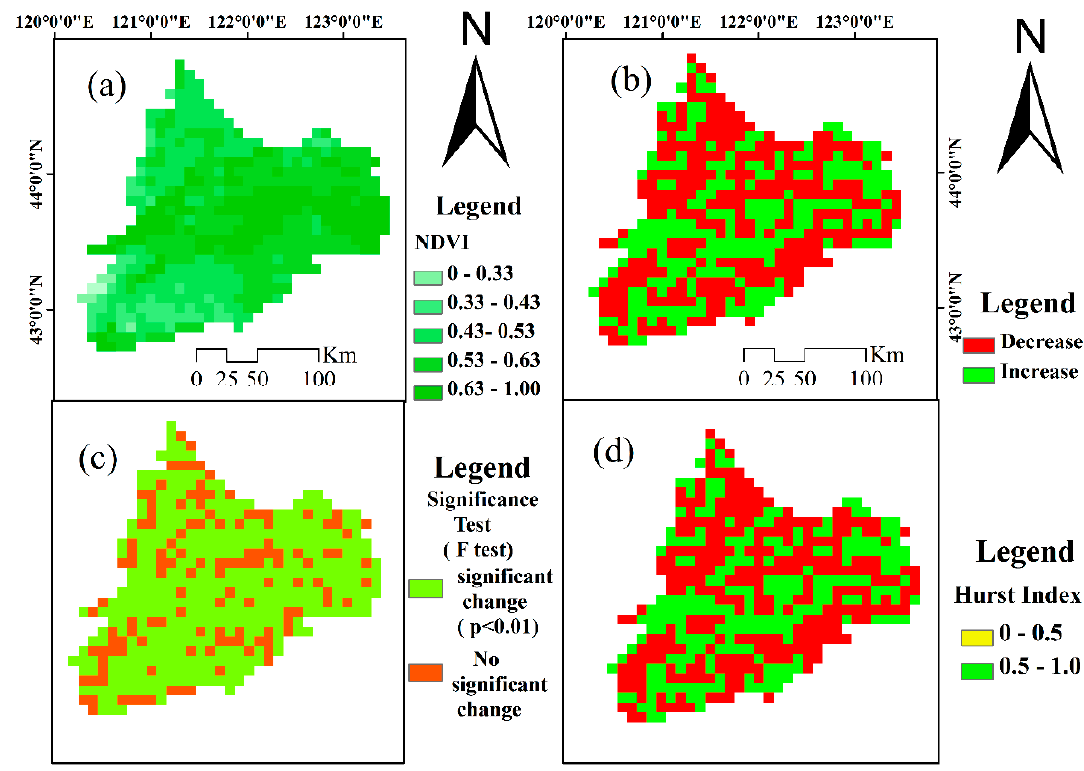
Figure 7. Spatial distribution of annual NDVI value ( a ), annual variation trend ( b ), F test results ( c ), and Hurst index ( d ) from 2002~2014 (Grid cell size: 8 km).